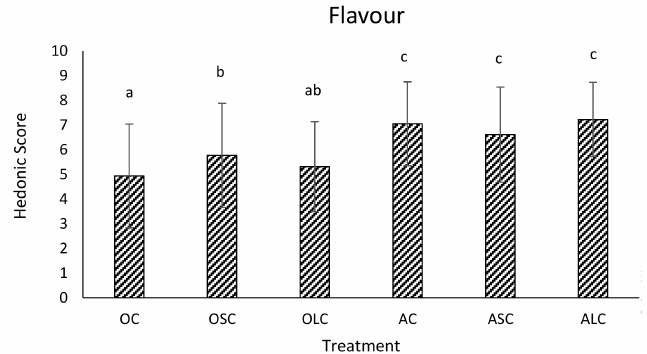
Figure 4. The hedonic scores (Mean ± SD) on the flavour of all six fruit juice samples from the panellists. The same letter above each bar graph indicates that there was no significant difference ( p > 0.05), while bar graphs with different letters indicate that there was a significant difference ( p < 0.05) according to Tukey’s studentized range test. OC, OSC, OLC (orange juice control, short chain and long chain inulin fiber).